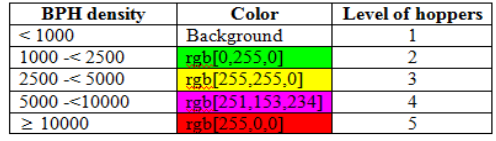
Figure 7. Ascendinglevels of infestedBPHs in light